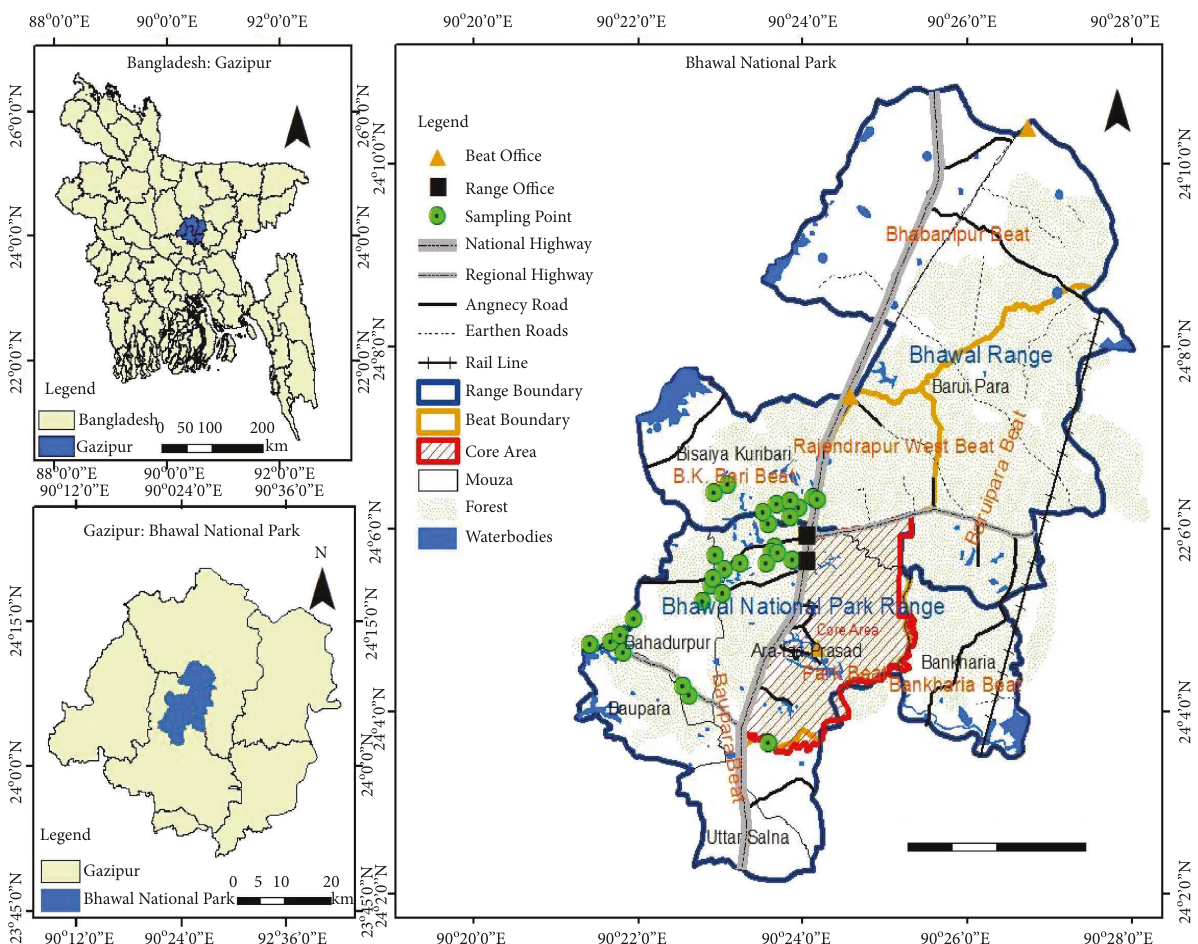
Figure 1: Location map of the study area showing the selected industries as sampling points (source: the author).